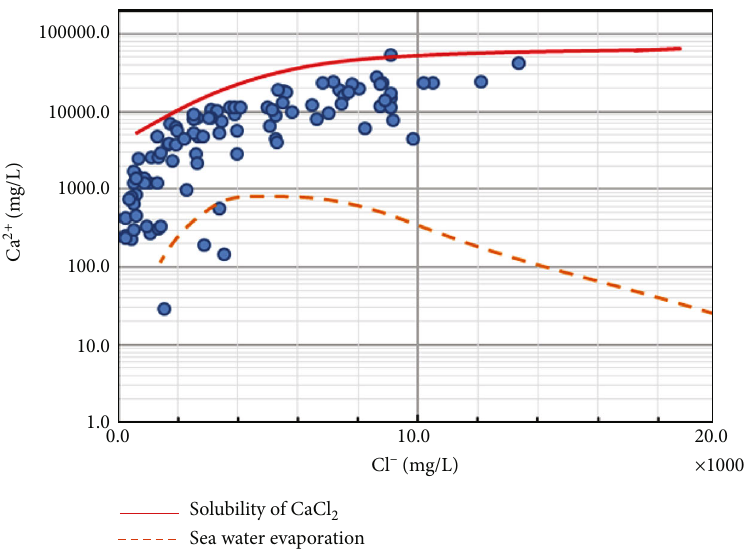
Figure 7: Comparison of Ca 2+ vs Cl − crossdiagram and theoretical evaporative dissolution curve.